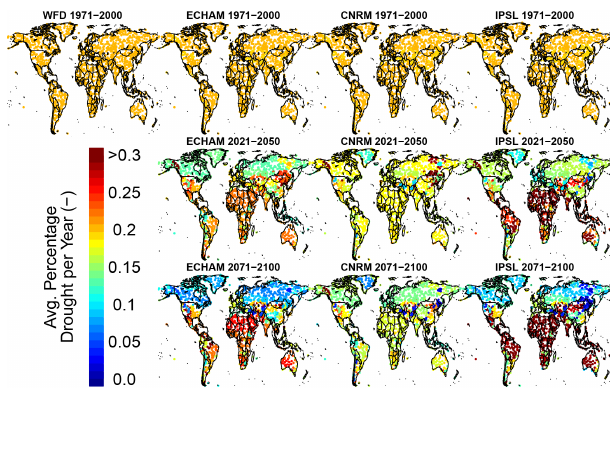
Figure 8. Spatial distribution of average percentage drought per year for different time periods, obtained from simulations of the conceptual hydrological model, using meteorological forcing by the WATCH Forcing Data (WFD) and GCMs: ECHAM, CNRM